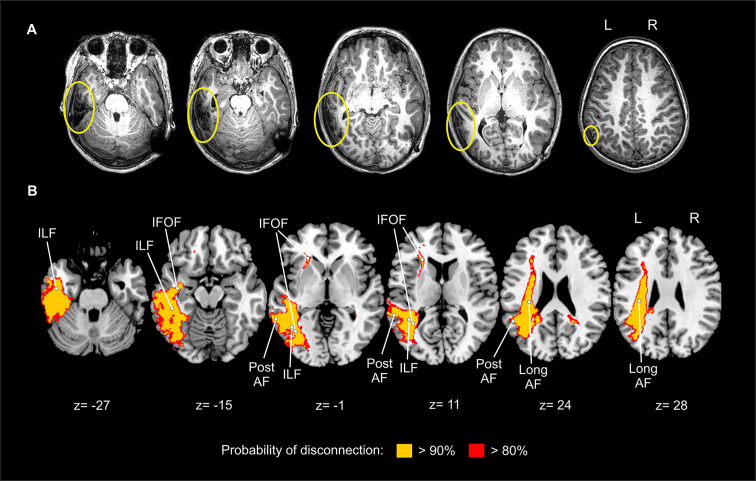
Depiction of the brain lesion and disconnection pattern. (A) MRI T1-weighted image showing the lesion in the left temporo-parietal cortex in native space. Yellow circles indicate brain lesions. (B) Probability of disconnection of brain areas not directly affected by the lesion as revealed by the Disconnectome map software. Two different probability thresholds are presented. The disconnection map is overimposed on a brain template in standard MNI space. L, left; R, right; ILF, inferior longitudinal fasciculus; IFOF, inferior fronto-occipital fasciculus; post AF, arcuate fasciculus posterior segment; long AF, arcuate fasciculus long segment.